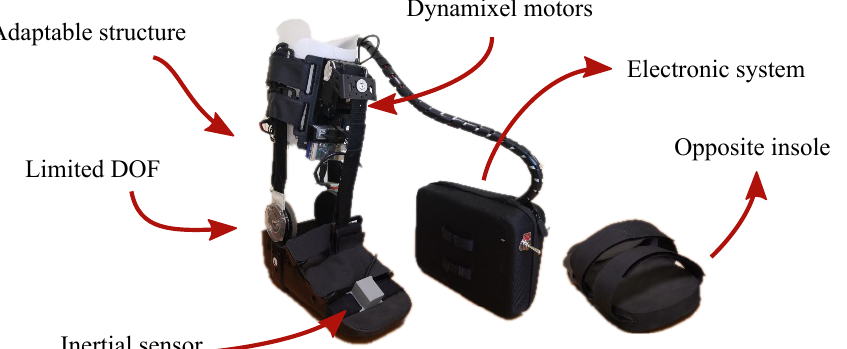
Figure 2. The actuation system of the T-FLEX exoskeleton that was implemented on the passive orthotic structure. The insole of the left part is added to the non-paretic limb to compensate for the effect due to the device’s